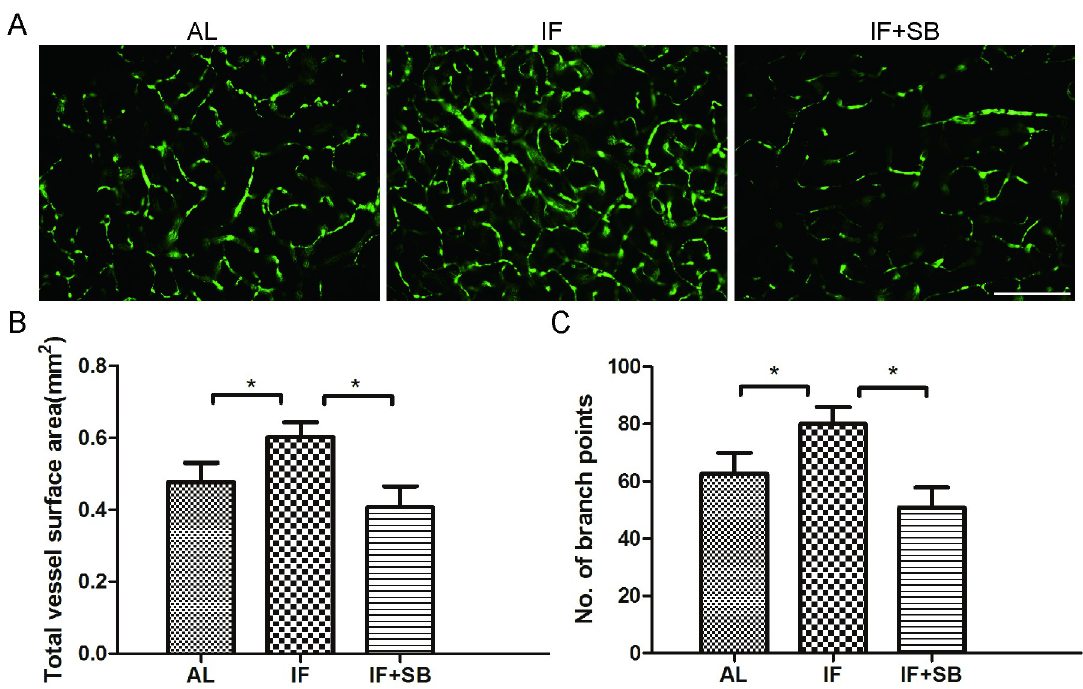
Fig 5. Long-term IF conditioning promotes functional perfusion of microvessels in the peri-infarct area 14 d after CI. ( A ) Cerebral functional microvessels labeled with FITC-dextran in each group. Scale bar, 200 μ m. Bar graphs showing total vessel surface area ( B ) and the number of vessel branch points ( C ) in each group. * p < 0.01 (n = 8/group).